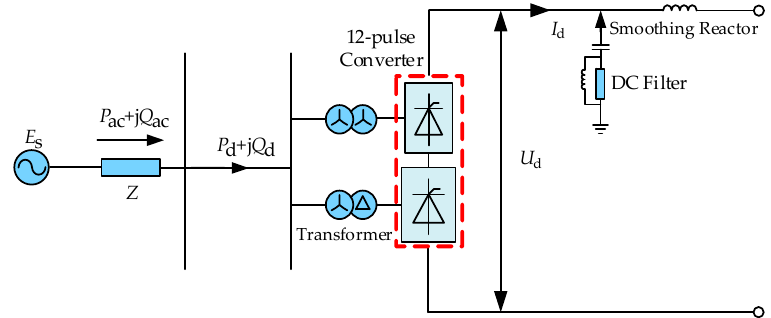
Figure 4. Schematic diagram of 12 − pulse LCC converter.